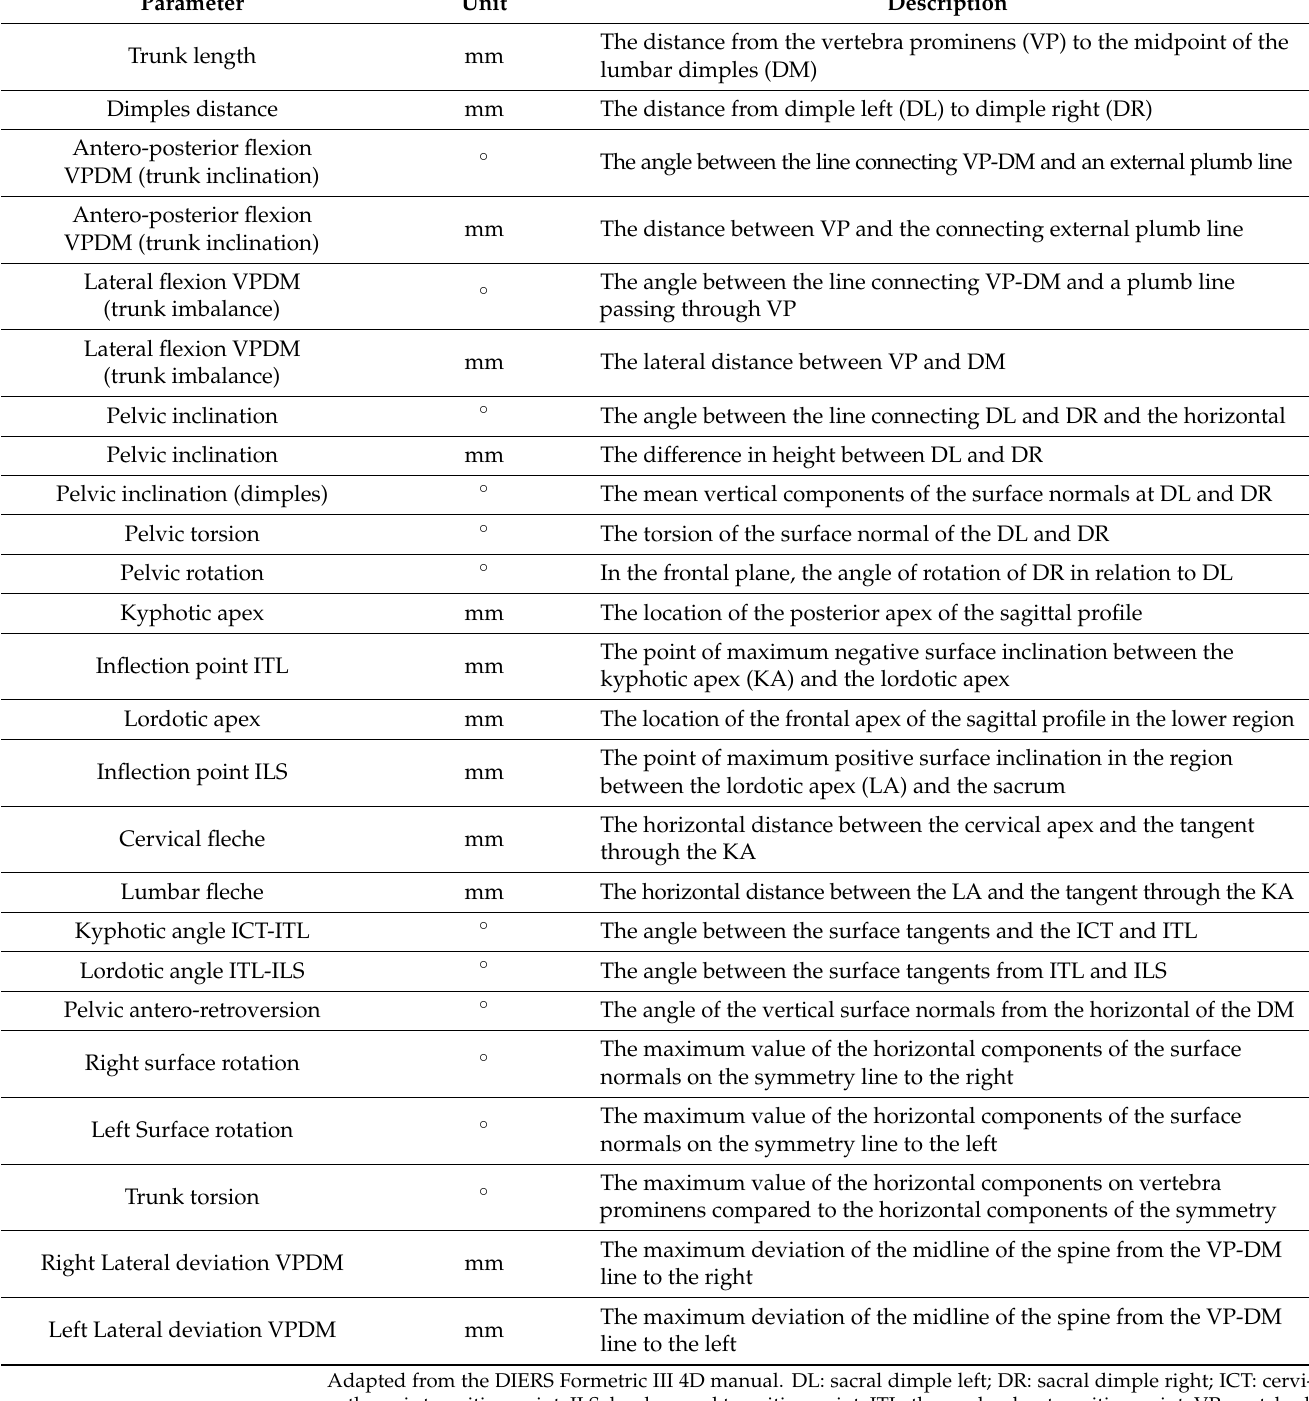
Table 2. Definitions of the spinal parameters measured by the Formetric 4D